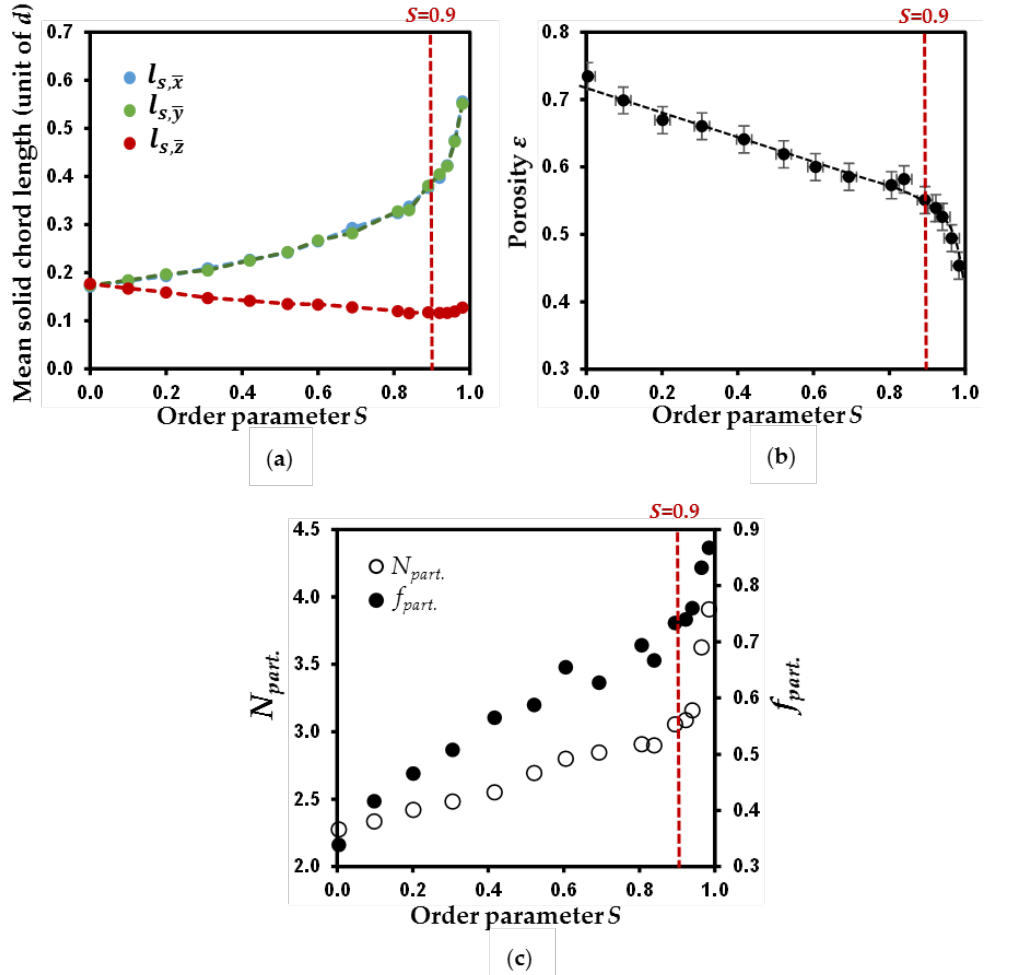
Figure 5. Evolution of geometrical parameters of the simulated porous media as a function of order parameter S . Mean chord length for the solid phase in the three main directions x, y, and z (i.e., 𝑙 𝑠,𝑥̅ , 𝑙 𝑠,𝑦̅ , and 𝑙 𝑠,𝑧̅ , respectively) ( a ), porosity ε ( b ) , and mean number of particles N part. and fraction of particles f part. in aggregates ( c ). Vertical dotted line is a guideline for the change noticed at S > 0.9. For S = 0, the isotropic organization of the packing is corroborated by the equal values for 𝑙 𝑠,𝑥̅ , 𝑙 𝑠,𝑦̅ and 𝑙 𝑠,𝑧̅ . Figure 5a also reveals that the increase in particle anisotropy leads to a progressive decrease of 𝑙 𝑠,𝑧̅ values and a gradual increase of 𝑙 𝑠,𝑥̅ and 𝑙 𝑠,𝑦̅ values. This evolution is fully consistent with the gradual alignment of particles axes and dimensions with that of the simulation box. Indeed 𝑙 𝑠,𝑧̅ dimension decreases toward a value close to d /10 (with d the disk diameter), i.e., the thickness of individual disk. Similarly, both 𝑙 𝑠,𝑥̅ and 𝑙 𝑠,𝑦̅ dimensions increase to approach the theoretical mean transverse dimension of the disk at ~0.63 d . Moreover, note that 𝑙 𝑠,𝑧̅ values slightly